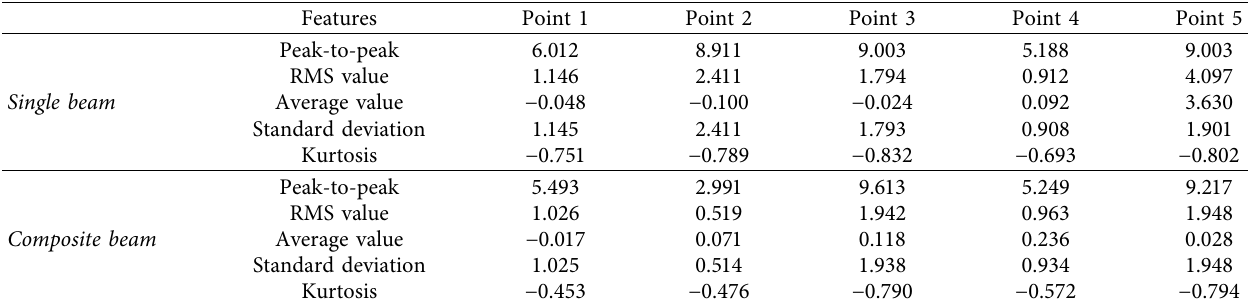
Figure 27: Vibration response of composite beams under different k values. (a) n � 1000r/min. (b) n � 1200r/min. Table 3: Statistics of waveform characteristics of acceleration signals of two structures.